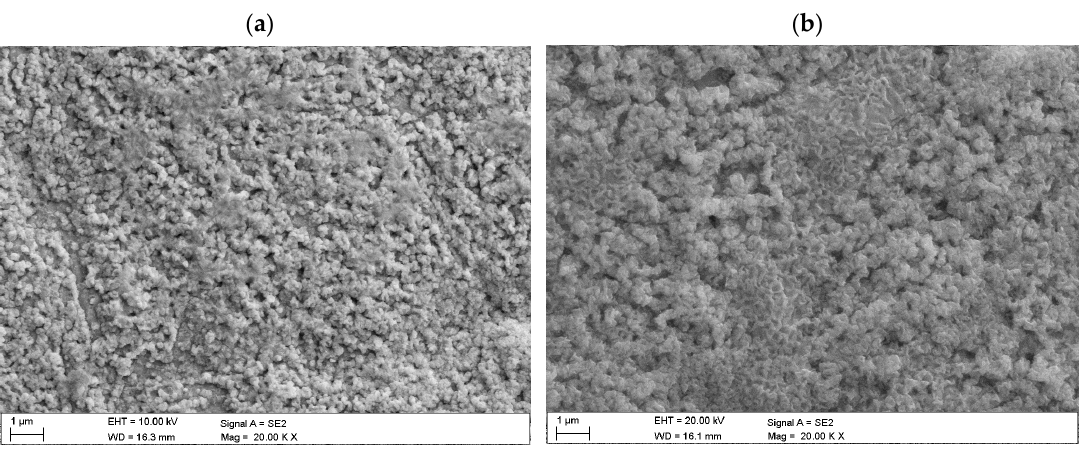
Figure 3. Surface topography of oxidised copper sheets (chosen example): ( a ) L1-1; ( b ) L2-4 (SEM).